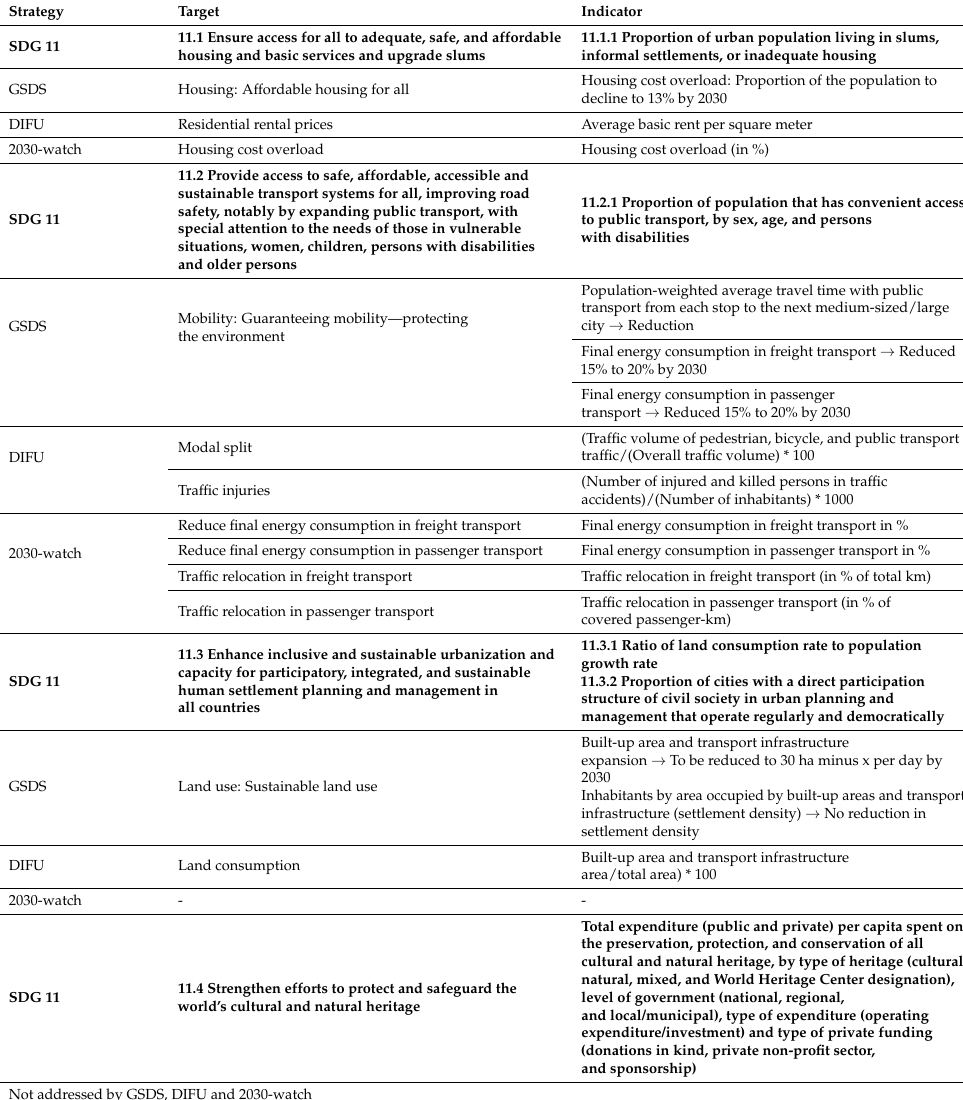
Table 4. Targets and indicators of United Nations (UN) SDG 11, the GSDS, the German Institute for Urban Affairs (DIFU) et al. project on SDG indicators for municipalities and the 2030-watch-project. Strategy Target